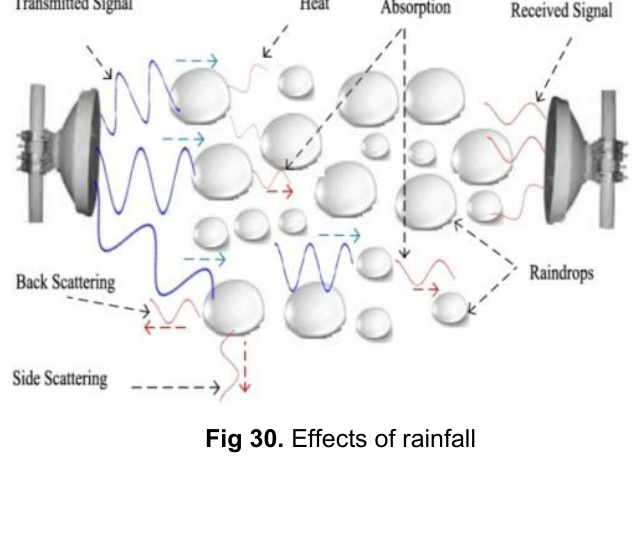
Fig 30. Effects of